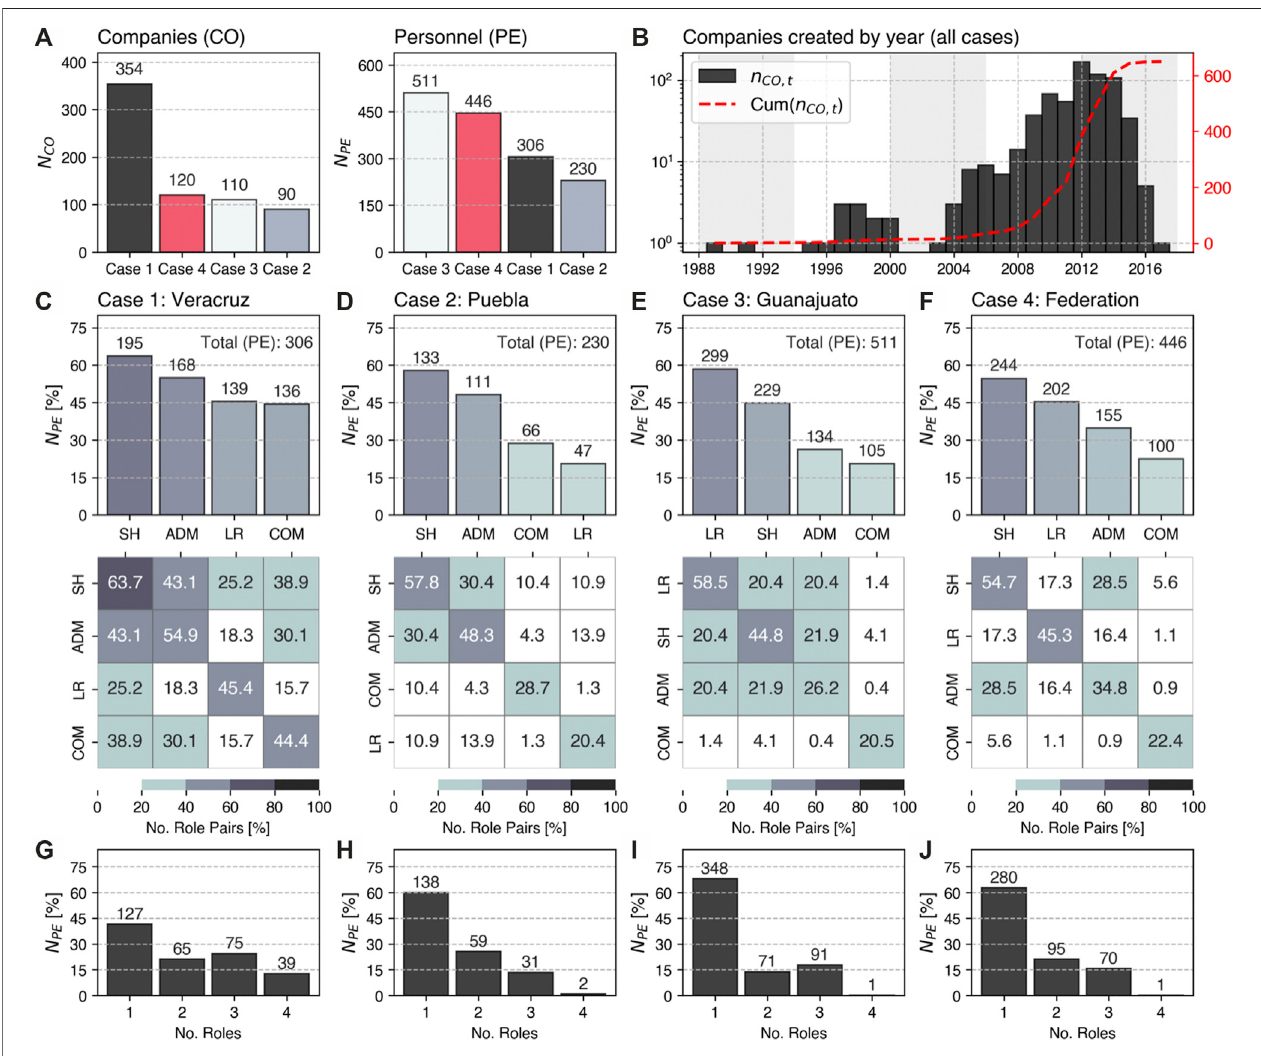
FIGURE 1 | Corporate features per case. (A) Number of companies and personnel, N CO and N PE , respectively. (B) Number and cumulative number of companies created yearly for all cases, n CO , t and Cum ( n CO , t ), respectively. Light and shaded bands correspond to different federal administrations. (C – F) Ownership and management statistics: (top) percentage of personnel according to its role within a company, with exact numbers also indicated; (bottom) role pair co-occurrence percentage matrix. (G – J) Percentage of personnel according to the number of possible role types, with exact numbers also indicated.